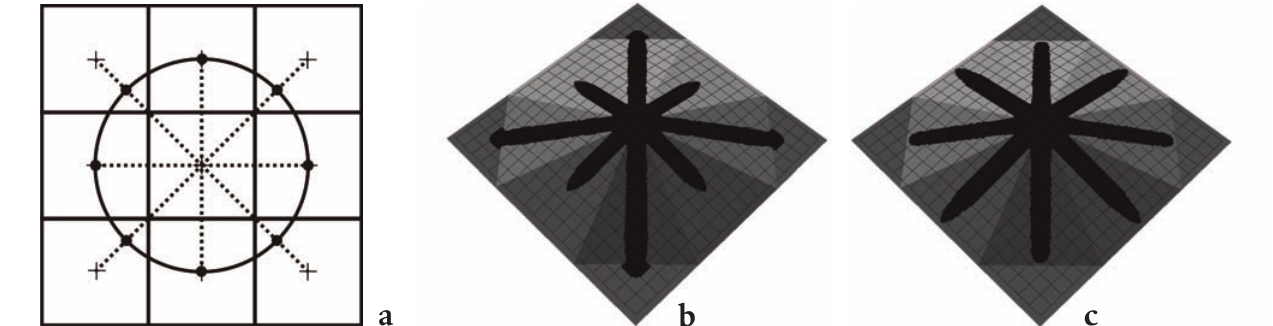
a b Figure 2. (a) Reference schema for the cell height determination in the Moore neighborhood. The heights of the cells along the von Neumann neighborhood correspond to DEM values. Those along diagonals are taken at the intersection between the diagonal line and the circle with radius w , such that the distance with respect to the centre of the central cell is constant for each adjacent neighbor; (b, c) SCIARA simulations on an octagonal-based pyramid with faces inclined by an angle (cid:0) a = 5˚, performed to evaluate the problem of the anisotropic flow direction when the actual cell topographic elevations are considered (b), and when the topographic corrections along the diagonals are considered (c). Note: the square lattice in panels (b) and (c) is only indicative of the cellular space orientation and does not correspond to the actual cellular space in terms of the number of rows and columns.